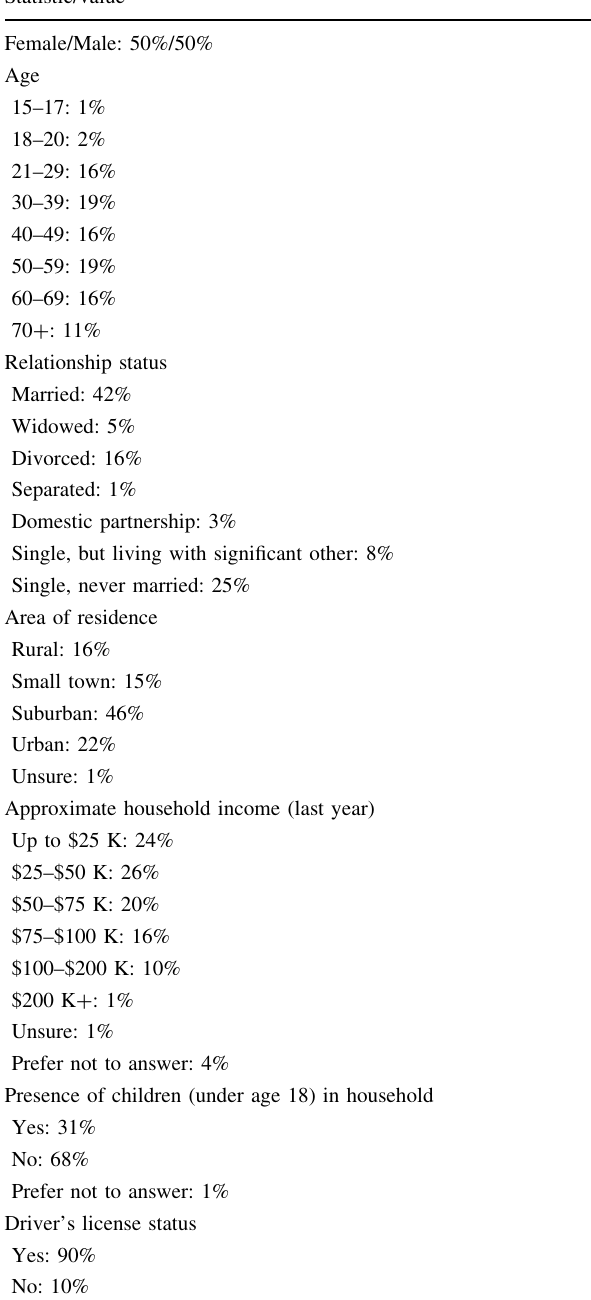
Table 2 Descriptive statistics of the